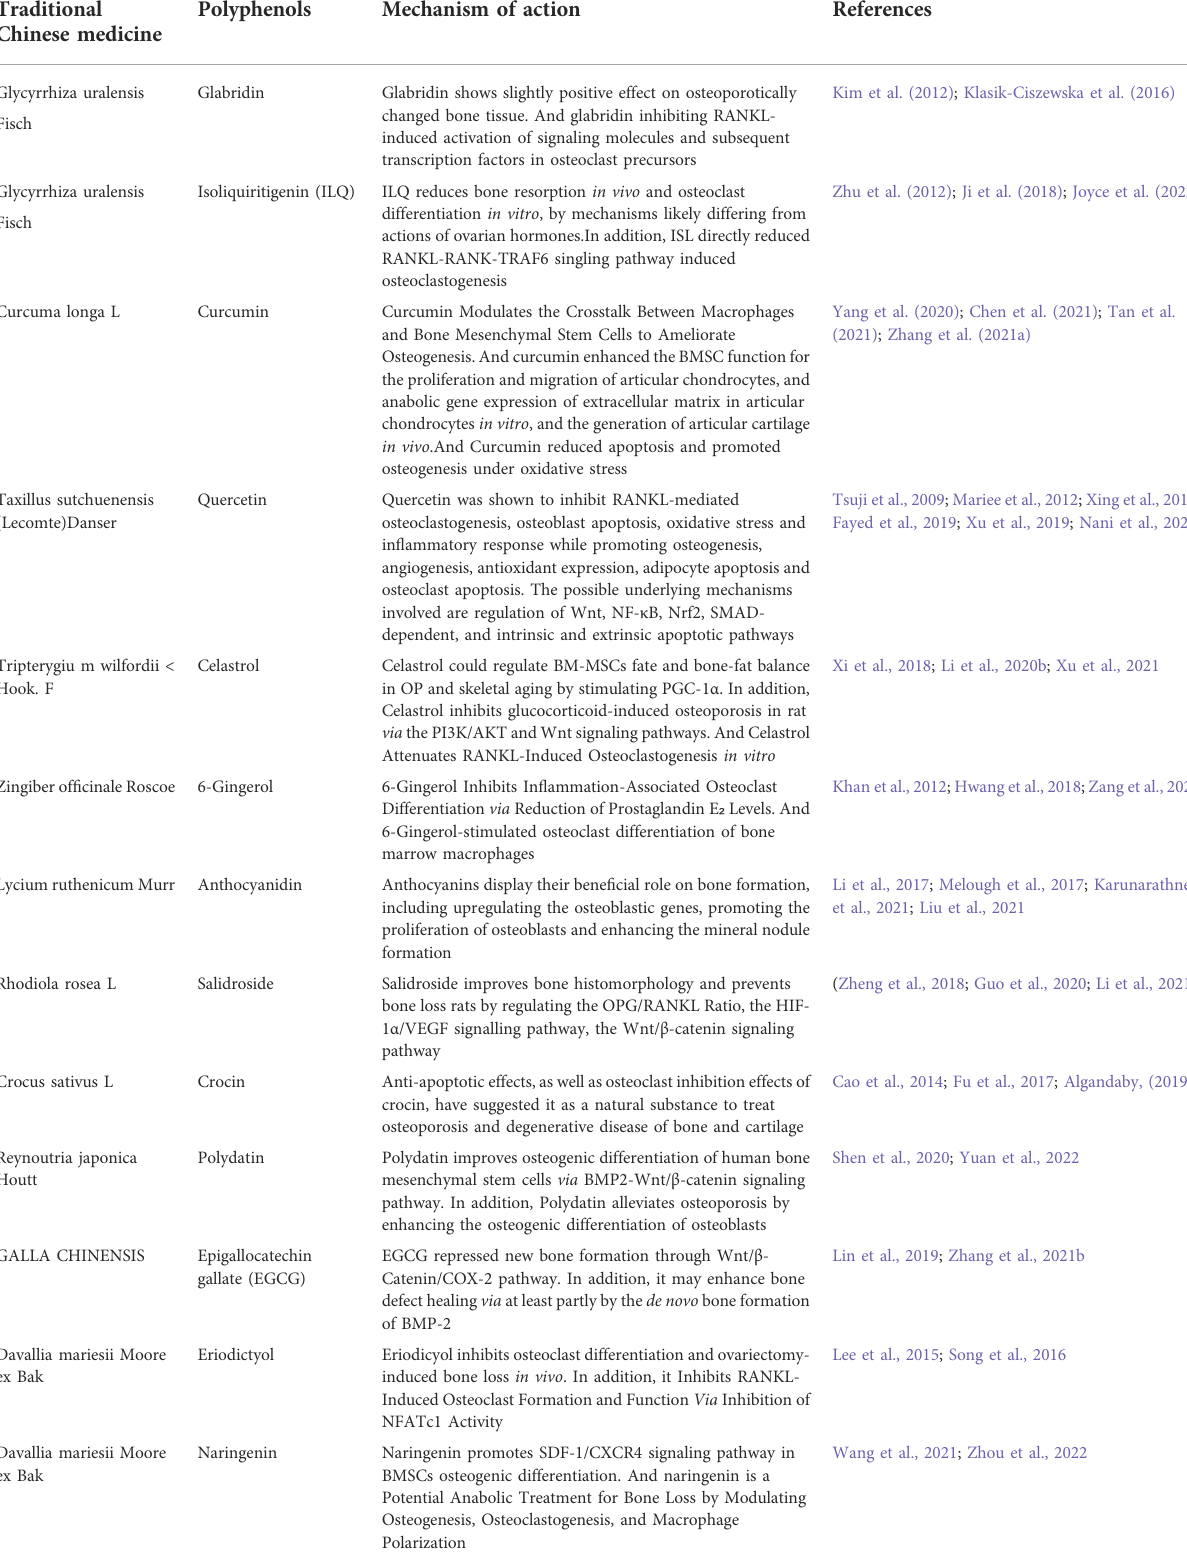
TABLE 1 List of Chinese herbal polyphenols connected with the mechanism of bone formation or resorption. Traditional Chinese